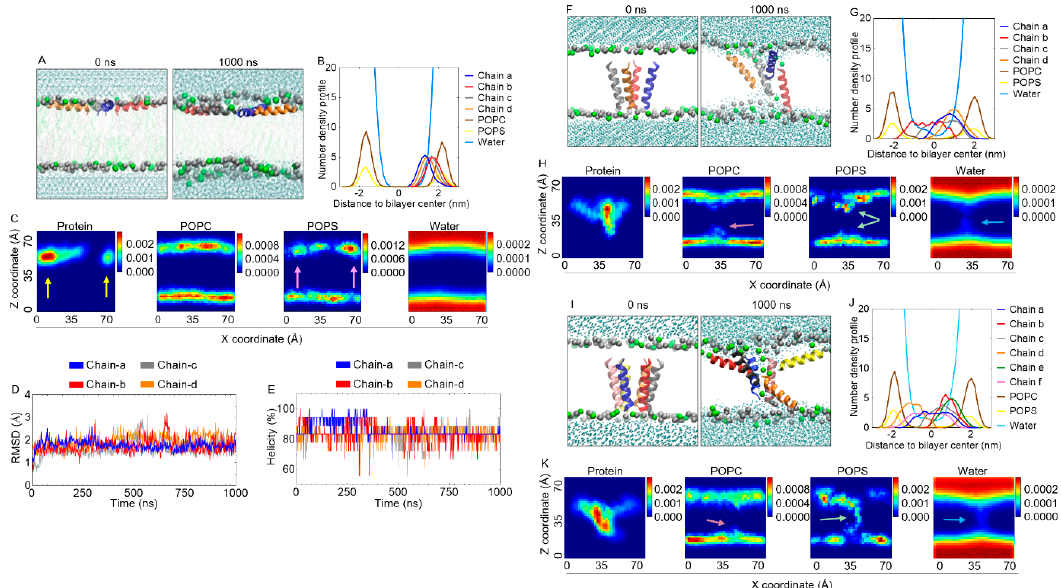
Figure 5. Molecular dynamics (MD) simulation of the interaction of B18L with model POPC/POPS membrane: ( A ) Initial (left, t = 0) and final (right, t = 1000 ns) snapshots of the interaction of B18L with POPC/POPS cell membrane. Color code: blue = B18L chain a, red = B18L chain b, gray = B18L chain c and orange = B18L chain d, silver particles = phosphate atom of POPC lipid, green particles = phosphate atom of POPS lipid, cyan dots = the oxygen atom of water. ( B ) One-dimensional (1D) and ( C ) two-dimensional (2D) density of the simulation system. Yellow arrows: enrichment of B18L molecules. Pink arrows: enrichment of POPS lipid heads. ( D ) RMSD and ( E ) helicity of each individual B18L peptide as a function of time for surface status. ( F ) Initial (left, t = 0) and final (right, t = 1000 ns) snapshots of four B18L peptides interaction with POPC/POPS cell membrane. Color code: same as Figure 5A. Lipid tails were not shown for clarity. ( G , H ) 1D and 2D density of the simulation system. Pink arrow: bent POPC lipid heads. Light green arrows: bent POPS lipid heads. Light blue arrow: water channel. ( I ) Initial (left, t = 0) and final (right, t = 1000 ns) snapshots of six B18L peptides interaction with POPC/POPS cell membrane. Color code: yellow: B18L chain e, pink: B18L chain f and the rest are the same as Figure 5A. Lipid tails were not shown for clarity. ( J , K ) one dimensional (1D) and two-dimensional (2D) density of the simulation system. Color codes for the arrows are as described for Figure 5H.